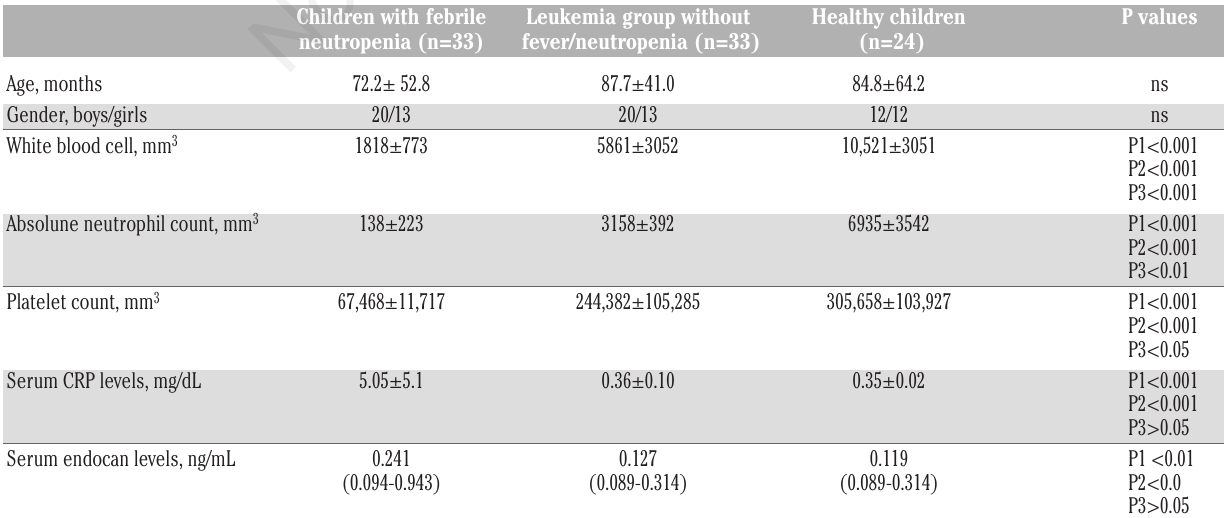
Table 1. Demographical and laboratory findings and serum endocan levels of study